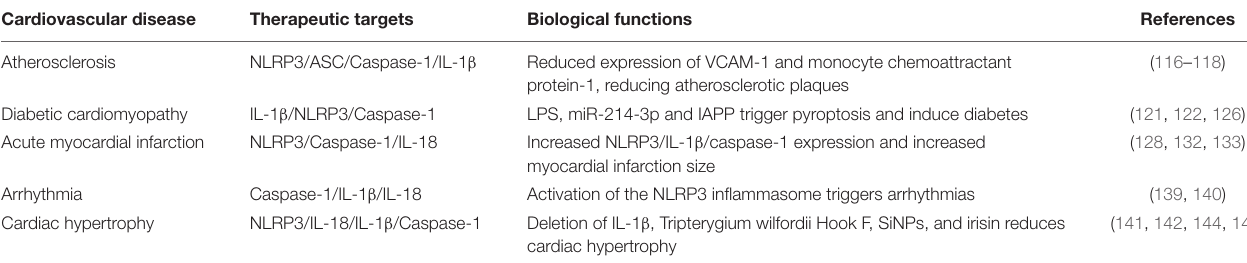
TABLE 3 | Pyroptosis and cardiovascular